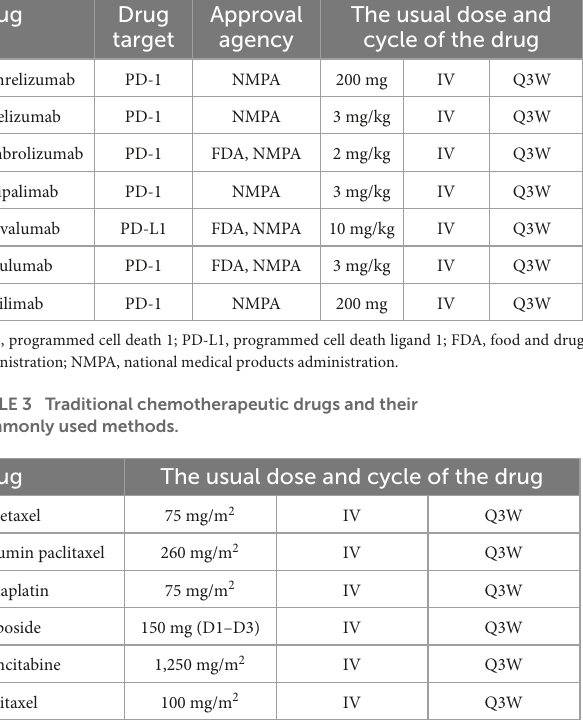
TABLE 2 The most commonly used immune checkpoint inhibitors (ICI) and their doses and frequencies. Drug